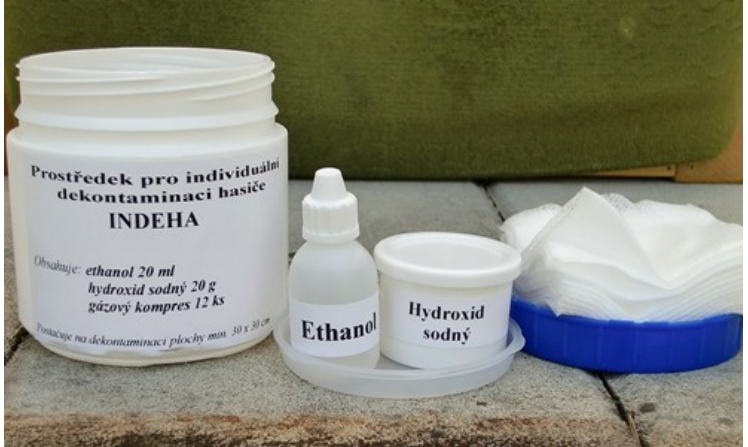
Figure 5. Components of the individual fire-fighter decontamination